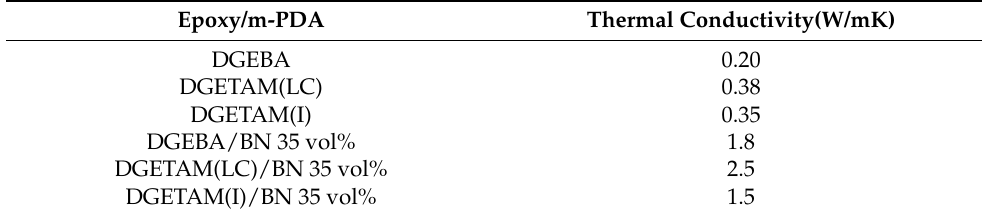
Table 2. Thermal conductivity of epoxy/m-PDA and epoxy/m-PDA/BN filler at 35 vol%.